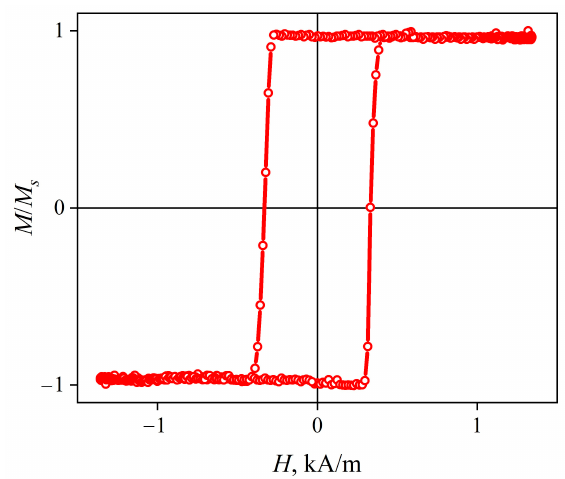
Figure 3. Longitudinal (measured along the wire axis) magnetic hysteresis loop of the composite wire CuBe/FeCoNi.